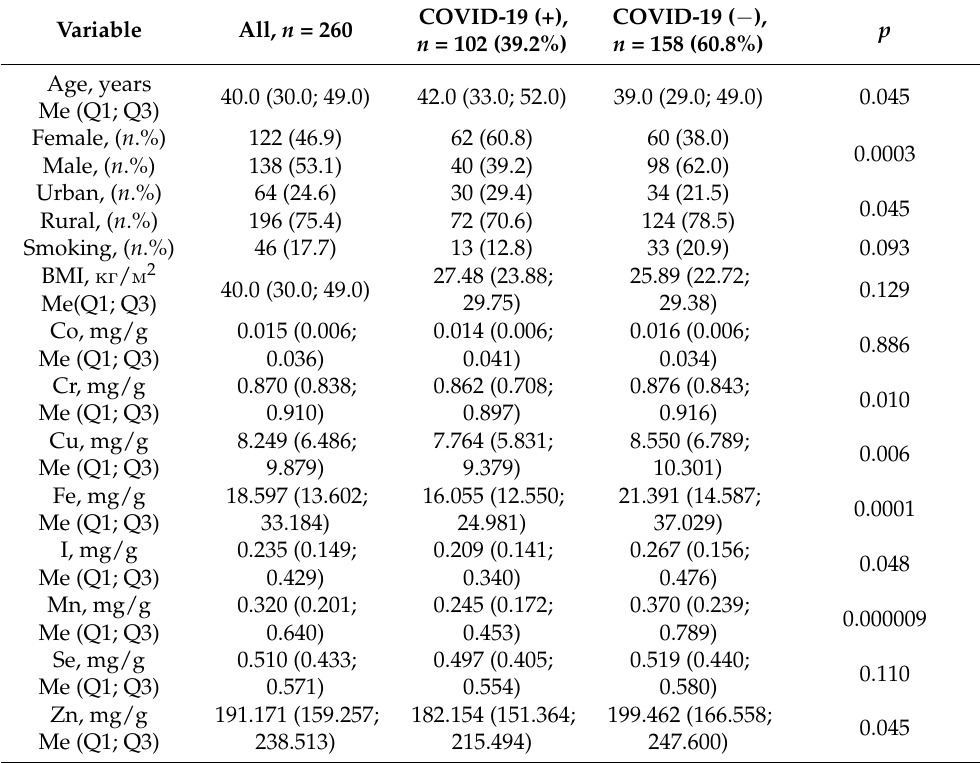
Table 1. Descriptive characteristics of study